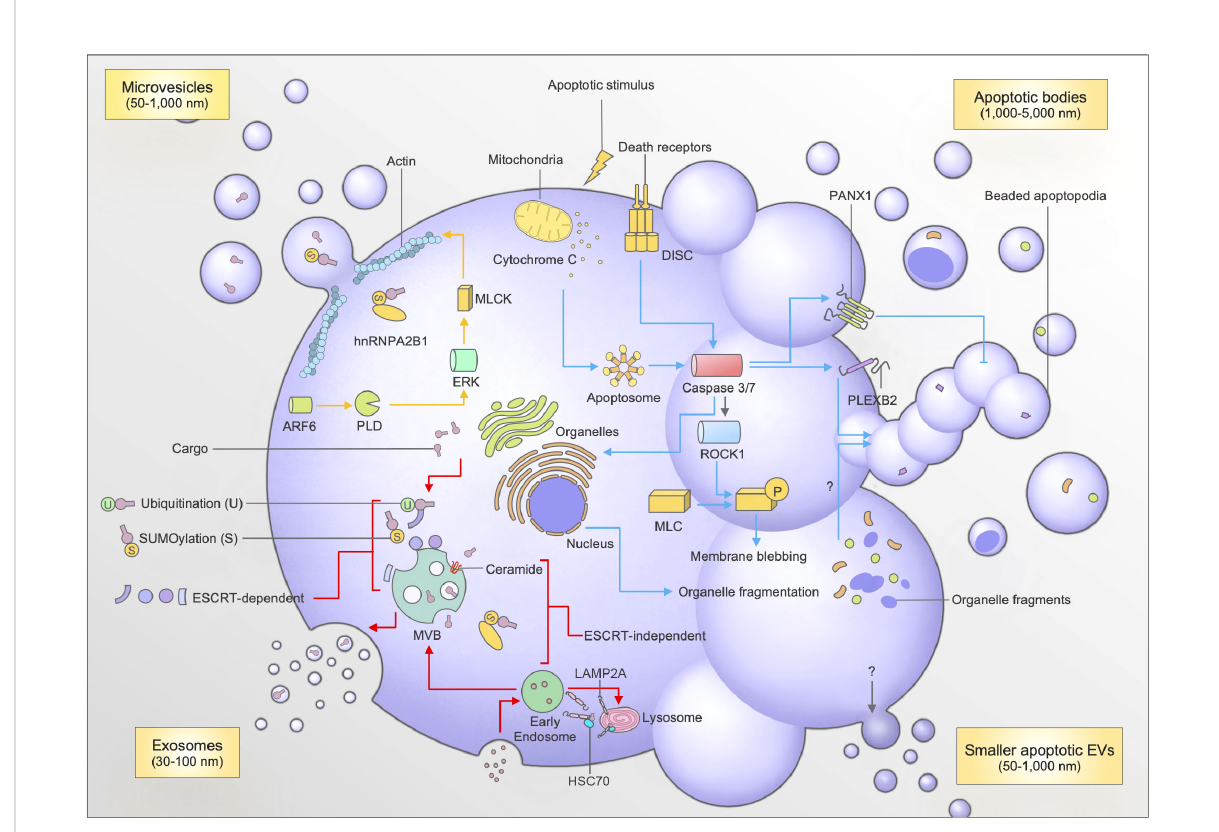
FIGURE 1 Mechanisms of biogenesis and cargo packaging for exosomes, microvesicles (MVs), apoptotic bodies (ApoBDs), and small apoptotic EVs. Exosome biogenesis (red arrows) involves the formation of intraluminal vesicles (ILVs) which contain cargo traf fi cked to the multivesicular body (MVB). The traf fi cking of cargo to the MVB involves post-translational modi fi cations like sumoylation and ubiquitination by proteins like hnRNPA2B1, and interaction between ESCRT machinery (ESCRT-dependent), or sphingolipid ceramide, and LAMP2A-HSC70 complexes (ESCRT-independent). The fusion of the MVB with the plasma membrane causes the release of exosomes into the extracellular milleu. The formation of microvesicles (yellow arrows) occurs through plasma membrane budding, which requires actomyosin contractions facilitated by ARF6. Apoptotic bodies are generated following an apoptotic stimulus (blue arrows), which facilitates the induction of the extrinsic (death receptor mediated) or intrinsic (mitochondrial) pathway of apoptosis. The subsequent formation of the Apoptosome or DISC activates caspases 3 and 7. Caspases 3 and 7 cleave and activate PANX1 (negative regulator of apoptotic cell disassembly), ROCK1 (to facilitate membrane blebbing), and PLEXB2 (regulator of beaded apoptopodia formation). Caspases 3 and 7 are also able to cleave proteins to aid organellar fragmentation, which can then subsequently be packaged into ApoBDs through an unknown mechanism. Apoptotic EVs are also released during apoptosis, however the mechanisms are currently